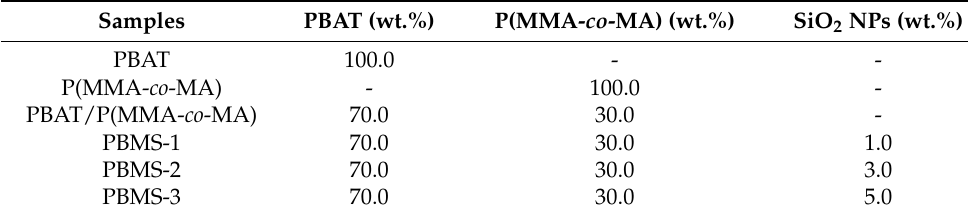
Table 1. Material formulation in blends and composite film